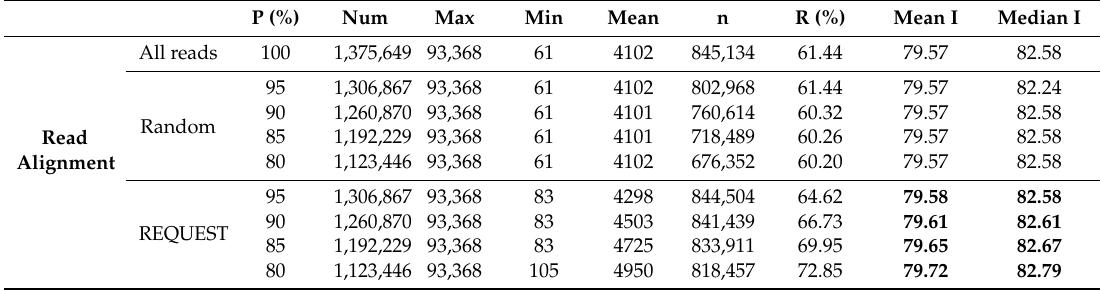
Table 3. Summary of the results of Drosophila biarmipes in selection, correction, and